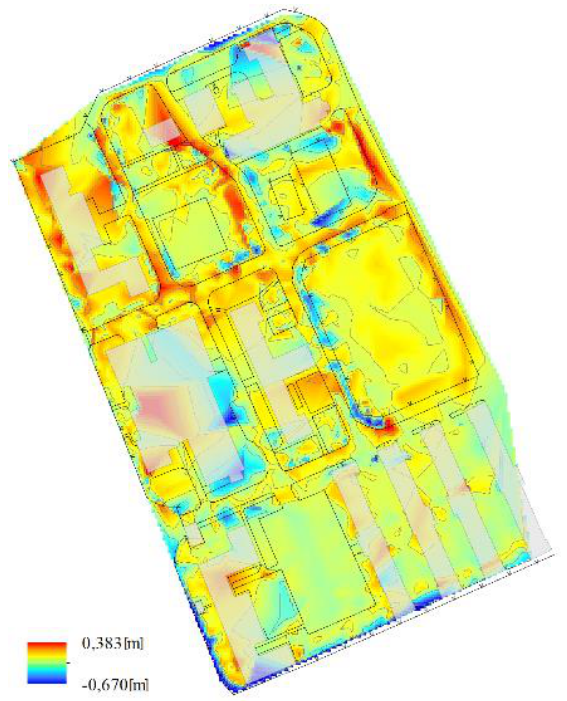
Figure 1. Spatial deviations distribution of DEM 5G in the Brno-Černá Pole area